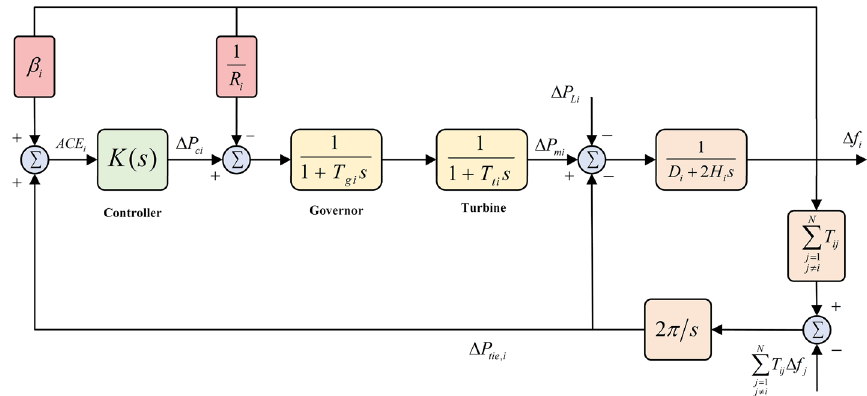
Fig. 1 Block diagram schematic of i th area power system used in the study